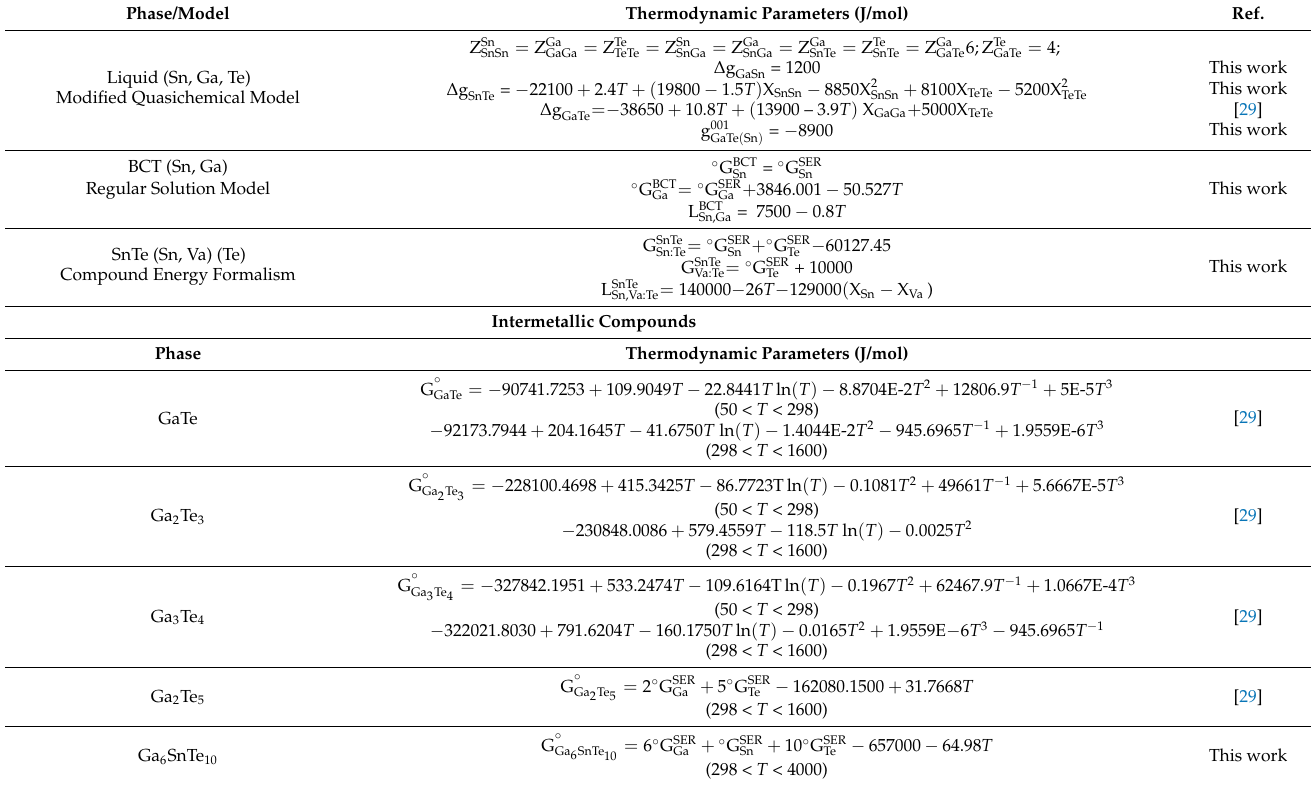
Table 1. Optimized model parameter of the Ga-Sn-Te system (All values are in J/mol).